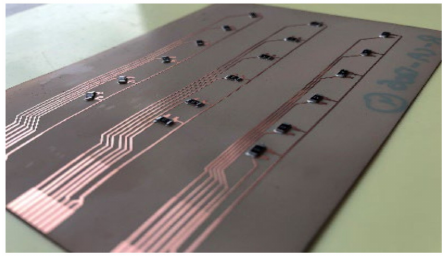
Figure 9. Real-life PI-Cu foil with components.